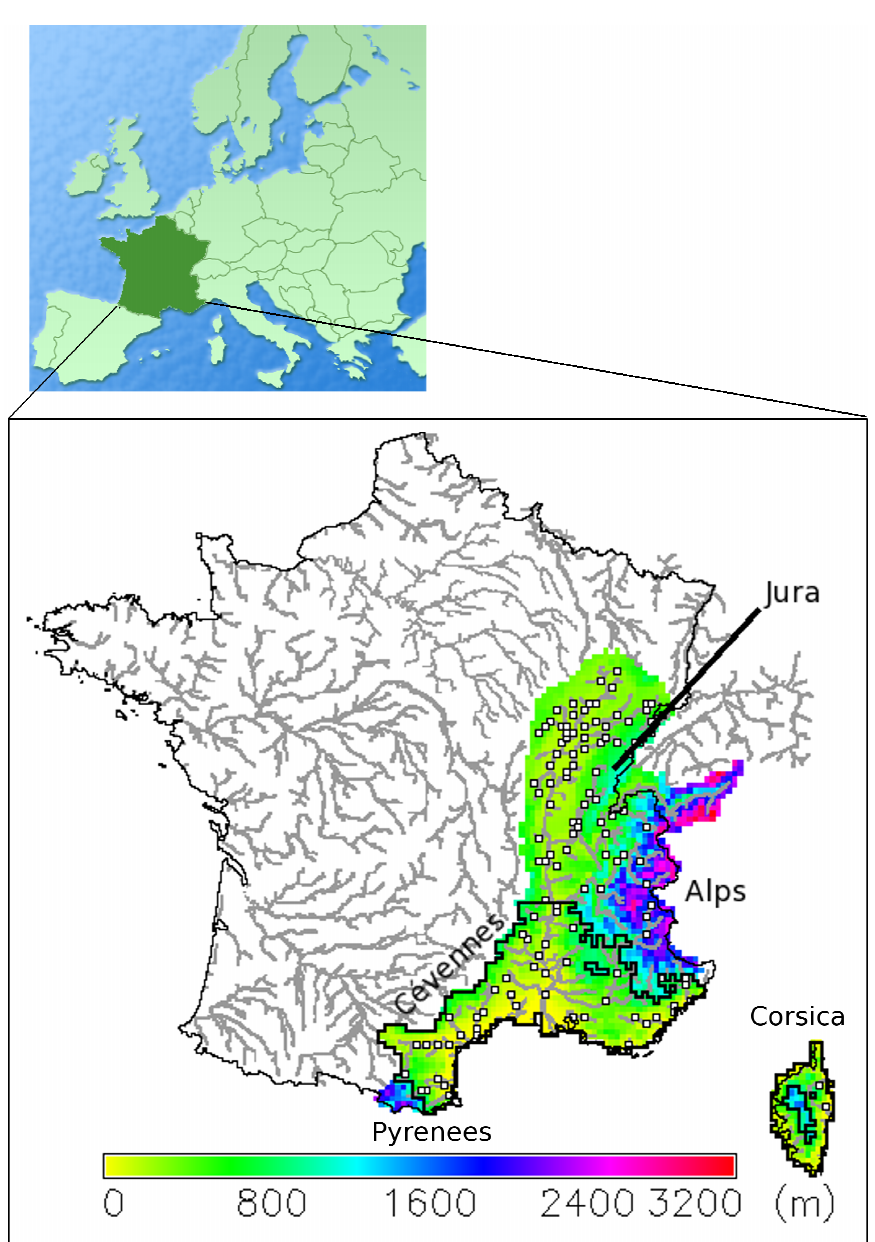
Fig. 1. Map of the domain studied (FullDom), indicating the elevation and the river network. The limit of the Mediterranean domain Figure 1: Map of the domain studied (FullDom), indicating the elevation and the river 3 (MedDom) is indicated by the black line. The River gauges used in this study are indicated by the white dots. network. The limit of the Mediterranean domain is indicated by the black line. The River 4 and Planton, 1989; Noilhan and Mahfouf, 1996) and the hy- gauges used in this study are indicated by the white dots. 5 drological model MODCOU (Mod´elisation coupl´ee nappe- surface, Ledoux et al., 1989). Usually, ISBA-MODCOU is forced by the SAFRAN meteorological analysis (described below in Sect. 4.2). In our study, ISBA-MODCOU is forced by data derived from climate